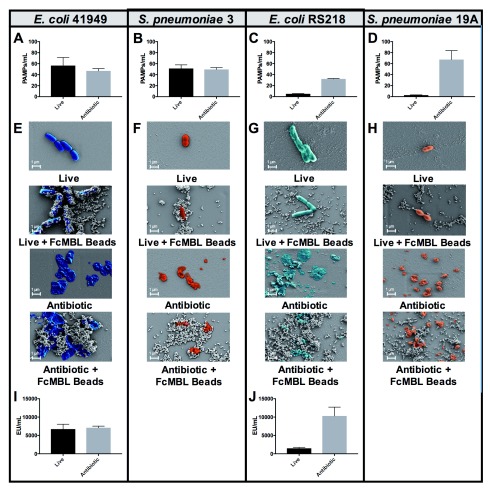
FcMBL bacterial binding efficiency can be enhanced with antibiotic treatment.(
A–
D) PAMPs/ml detection by FcMBL ELLecSA of both live (10
7 CFU/ml) and fragmented bacteria using antibiotics (cefepime 1 mg/ml or ceftriaxone 1 mg/ml). (
A)
E. coli 41949, (
B)
S. pneumoniae 3, (
C)
E. coli RS218, and (
D)
S. pneumoniae 19A. (
E–
H) Scanning electron microscopy images showing FcMBL bead (128 nm) capture of both live and fragmented bacteria using antibiotics (cefepime 1 mg/ml or ceftriaxone 1 mg/ml). (
E)
E. coli 41949, (
F)
S. pneumoniae 3, (
G)
E. coli RS218, and (
H)
S. pneumoniae 19A. (
I,
J) LPS endotoxin measurement (LAL assay) using 10
7 CFU/ml of both live and fragmented bacteria using antibiotics (cefepime 1 mg/ml). (
I)
E. coli 41949 and (
J)
E. coli RS218.